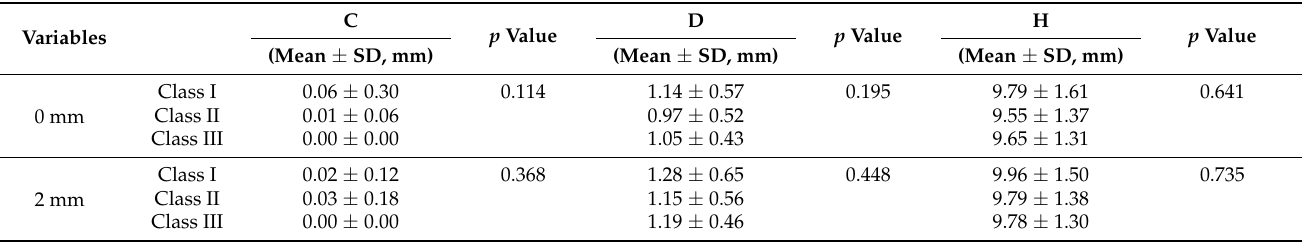
Table 3. From the base plane (0 mm) to 40 mm forward, the thickness (mm, mean ± SD) of the lingual cortical bone and marrow with their skeletal patterns in the One-way ANOVA with post hoc Tukey HSD test. Variables